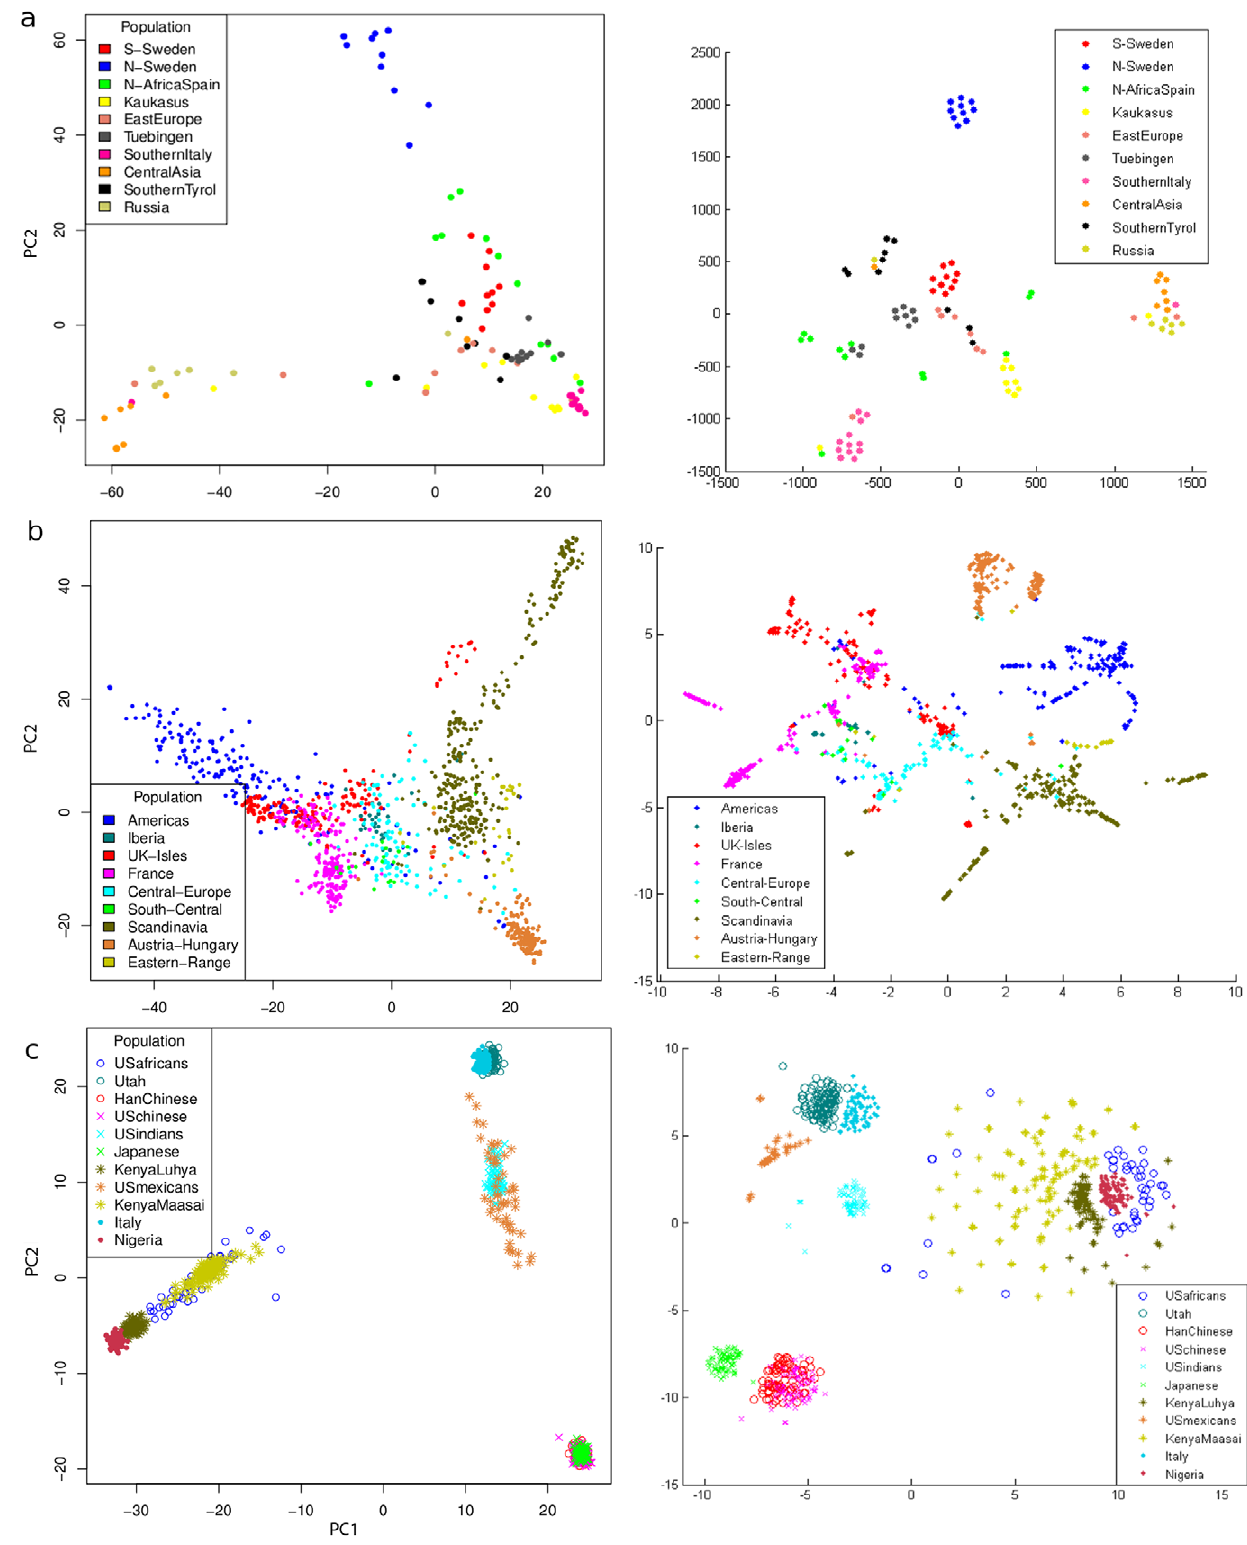
Figure 1. SNP data transformed with PCA and t-SNE 1/2. On the left is a PCA-plot with the first two components, on the right a t-SNE-plot of the very same data from each data source. Data sources: Panel (a) is from the 1001 genomes project, (b) from the RegMap panel and (c) from hapmap3 r2.